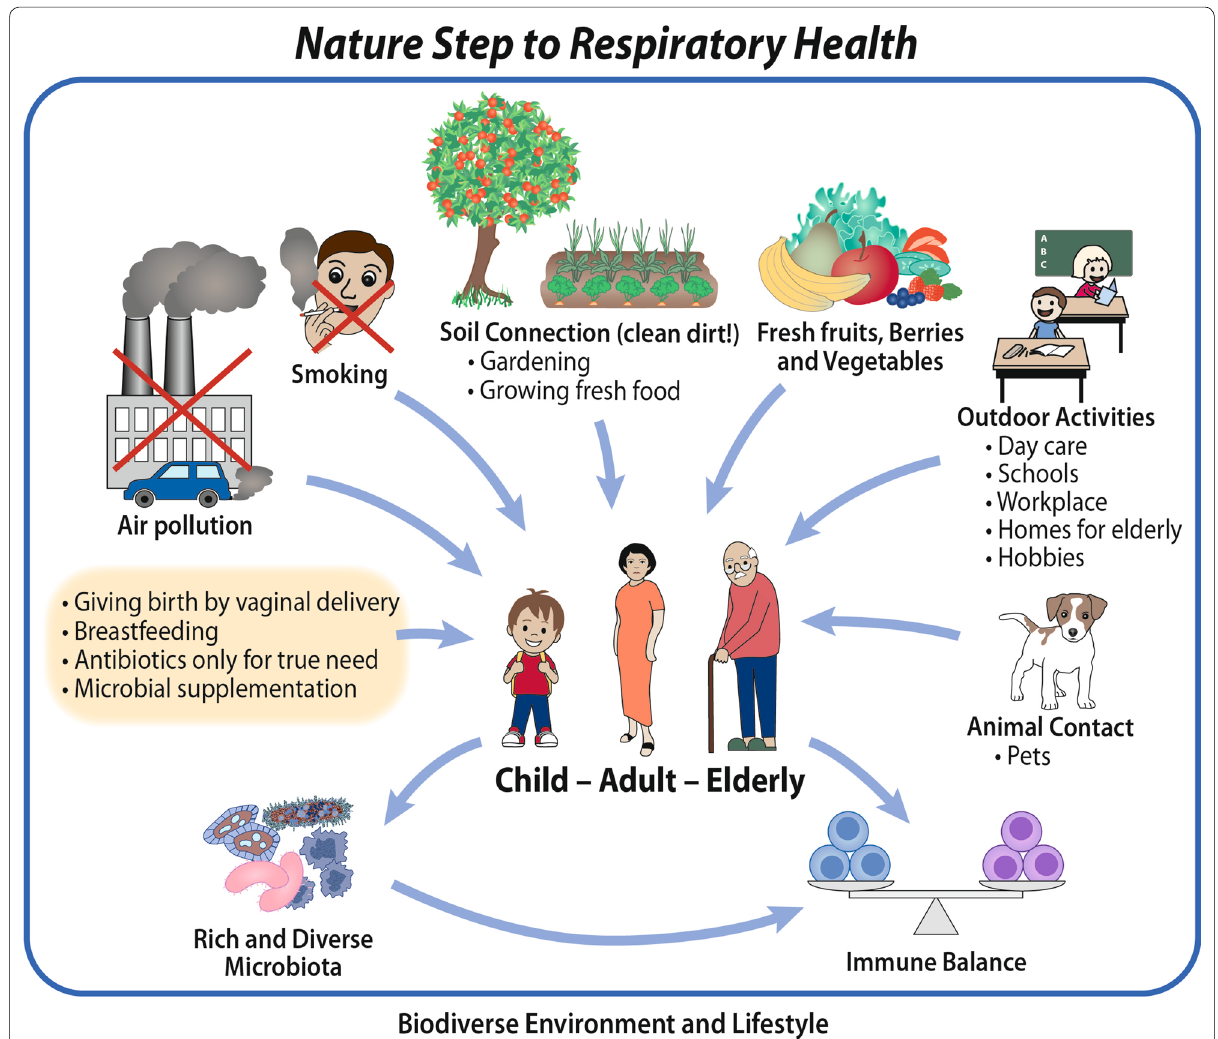
Fig. 2 The Nature Step to Respiratory